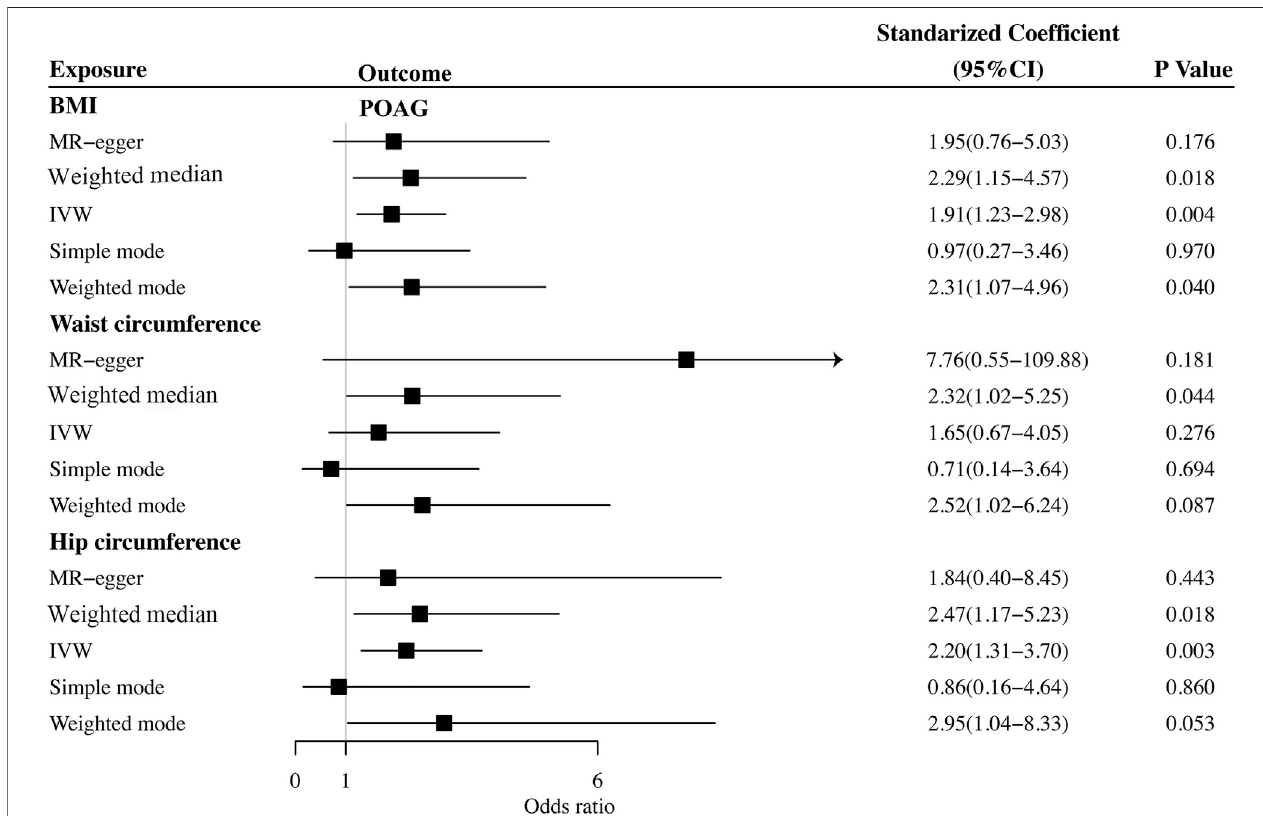
FIGURE 2 | Summary of Mendelian randomization analysis results of the cause of obesity on POAG. BMI: body mass index; IVW: inverse variance weighted; POAG: primary open-angle glaucoma; MR: Mendelian randomization.